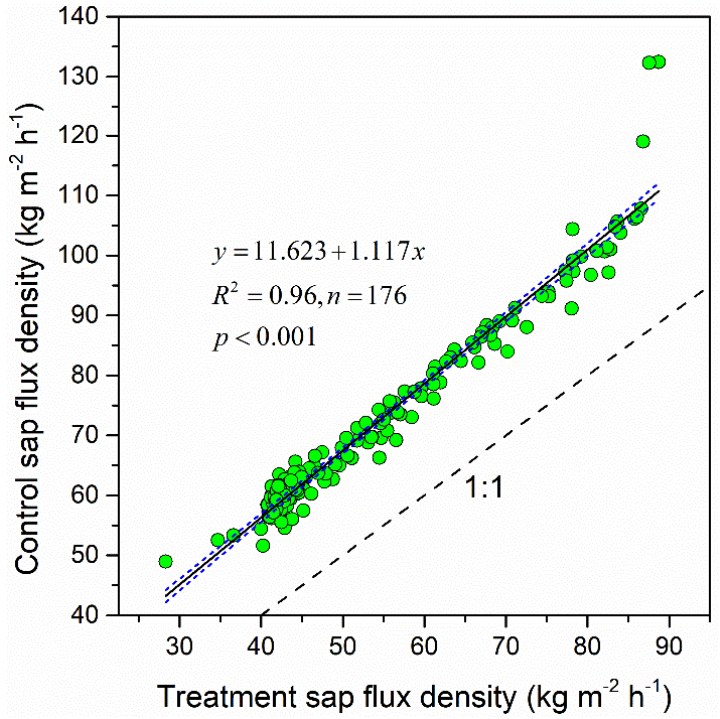
Figure 9. Relationship (black solid line) between the treatment and control groups in terms of the sap flux density, where the blue upper and lower dashed lines are the confidence intervals for the 95% level; the black dashed line is the 1:1 reference line. Table 5. Statistical results of two indexes between the treatment group and the control group.